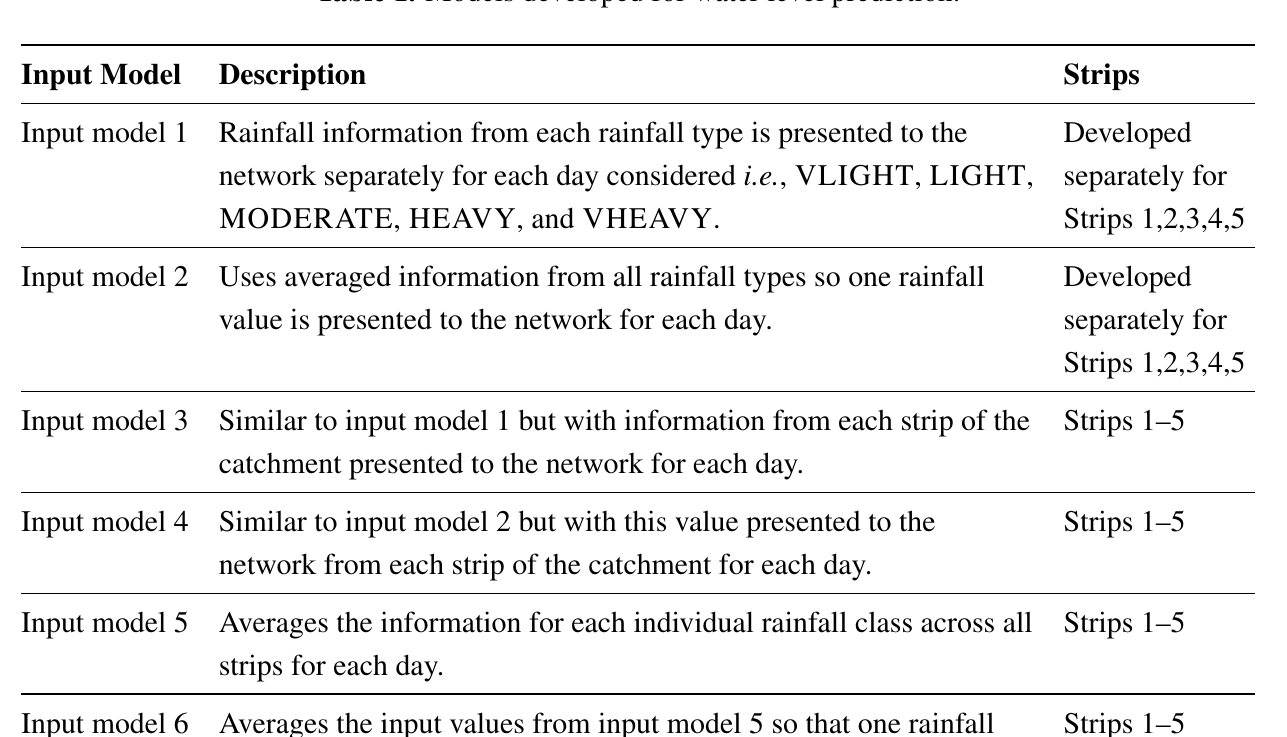
Table 1. Models developed for water level